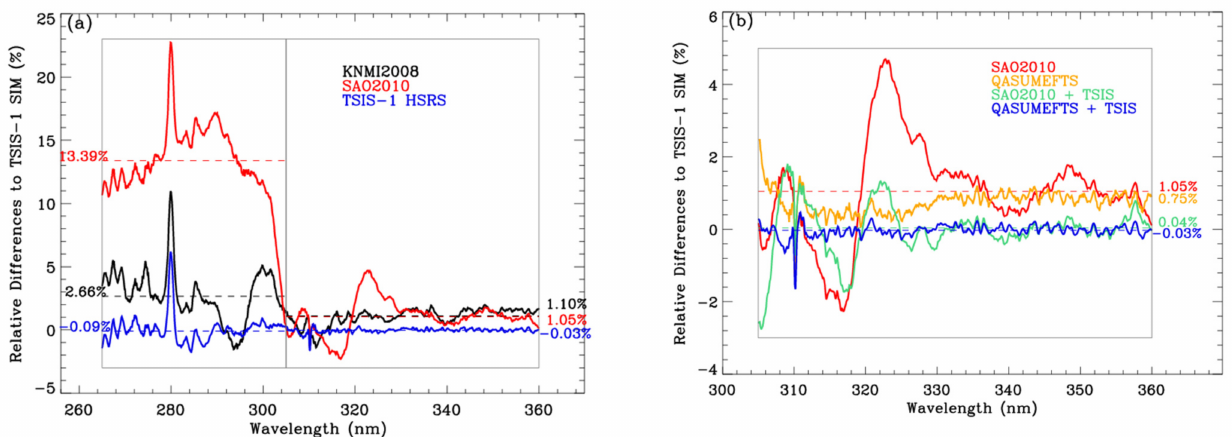
Figure 1. ( a ) Comparison of the three high-resolution solar reference datasets (KNMI2008, SAO2010, TSIS-1 HSRS) against the TSIS-1 SIM spectrum at the spectral resolution of the TSIS-1 SIM with the mean values of individual differences below and above 305 nm noted in the legend. ( b ) Same as ( a ) but for KPNO2005 and QASUMEFTS with and without the TSIS-1 SIM-based spectral adjustment,